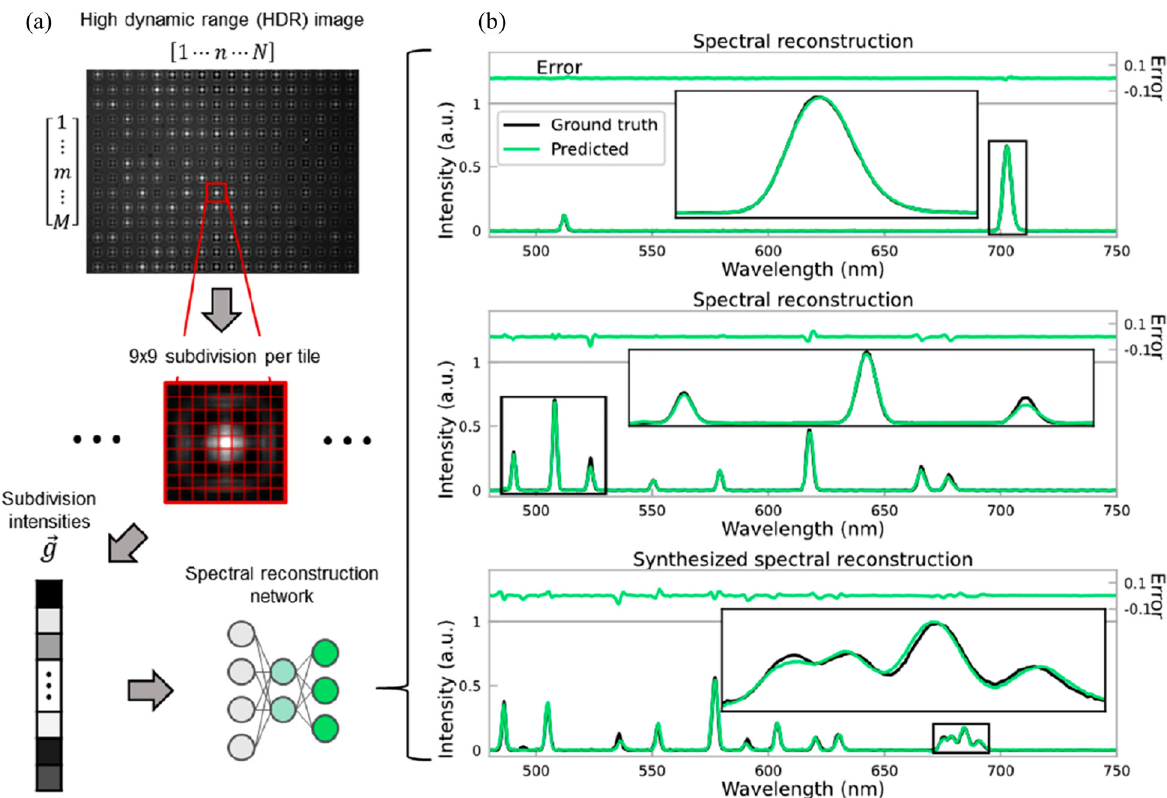
Figure 7: The application of a plasmonicencoderchip enabled onchip spectroscopy. (a) Workflow of spectral reconstructions. Regions of the HDRimagecorrespondingto eachtileareusedas inputsto thespectralreconstructionneuralnetwork. (b)Spectrareconstructedduring blind testing.Errorisshownaboveeachplotonthesamey-scale.Thenetworkwastrainedonlyonspectrawithuptoeightpeaks,yetitsuccessfully reconstructs a spectrum with 14 peaks. (a) and (b) are reprinted with permission from Ref. [38], copyright 2021 American Chemical